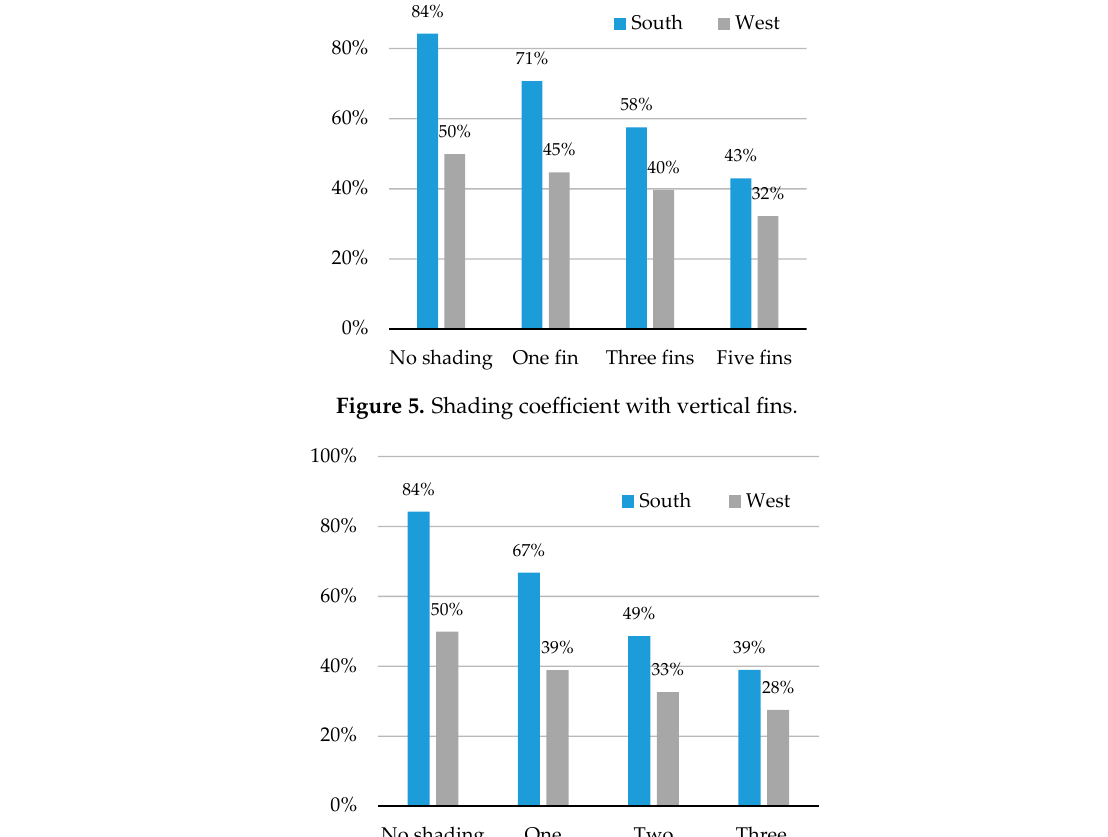
Figure 6 . Shading coefficient with horizon canopy.